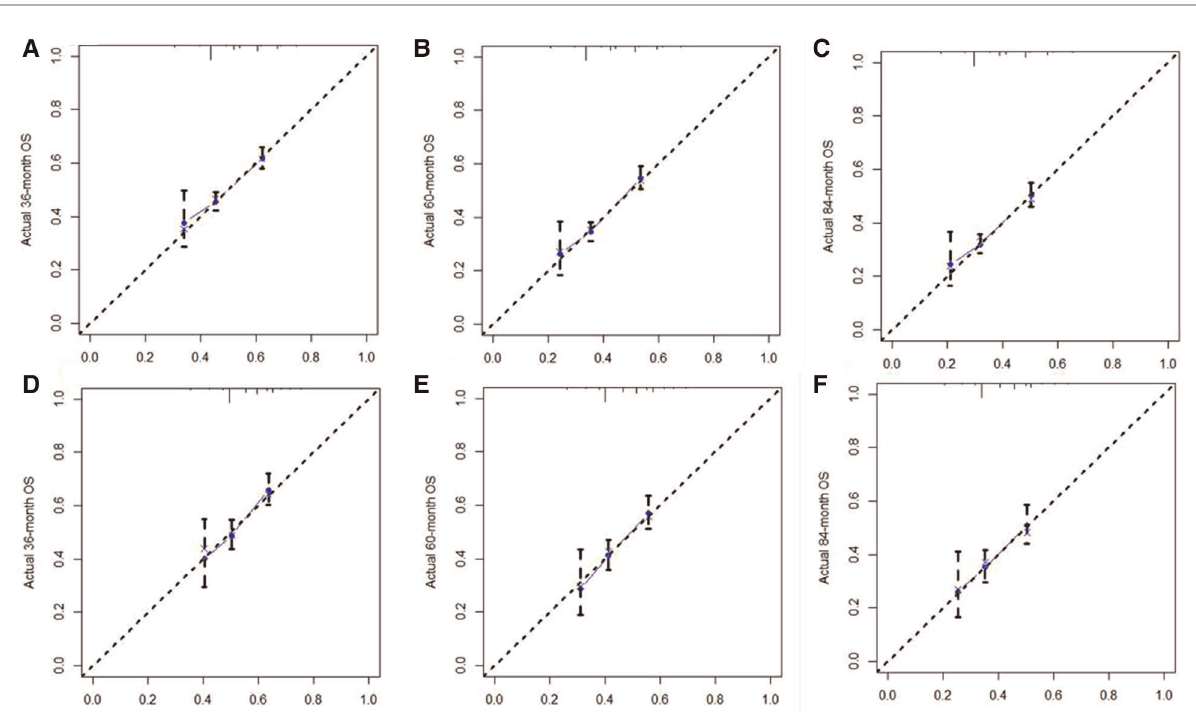
FIGURE 5 The calibration curve for predicting CSS at ( A ) 3-years, ( B ) 5-years, ( C ) 7-years in the training cohort,and at ( D ) 3-years, ( E ) 5-years, ( F ) 7-yearsin validation cohort. The nomogram-predicted probability of CSS is plotted on the X-axis, and the actual CSS is plotted on the Y-axis. CSS: cancer-speci fi c